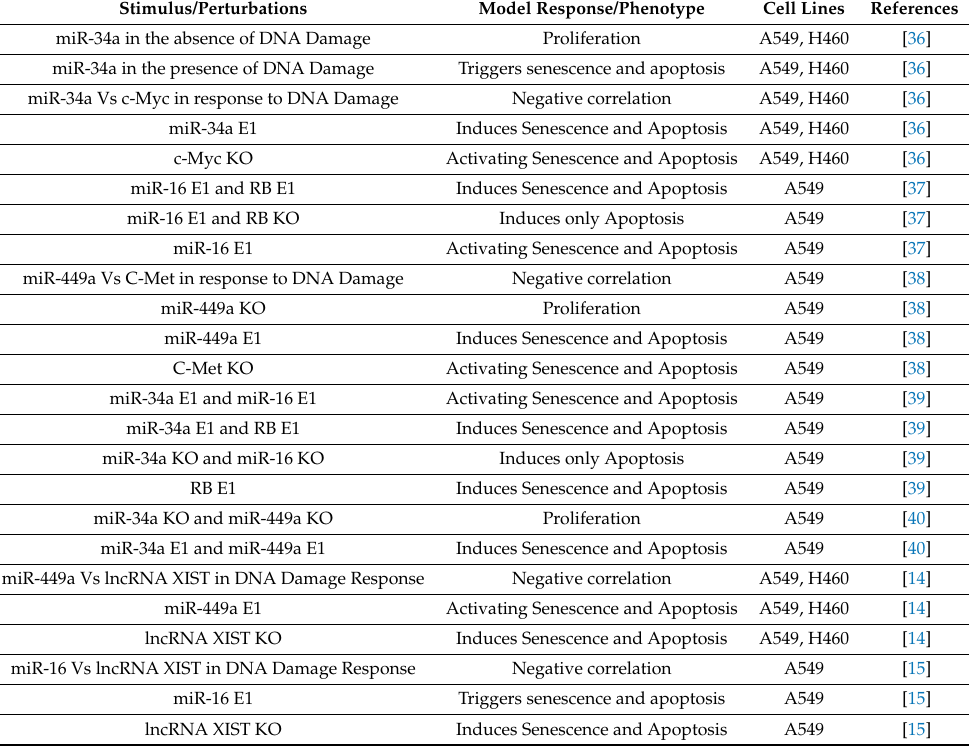
Table 1. Referential experimental studies used to develop the network. E1 represents gain of function (GoF) and KO stands for LoF of the corresponding